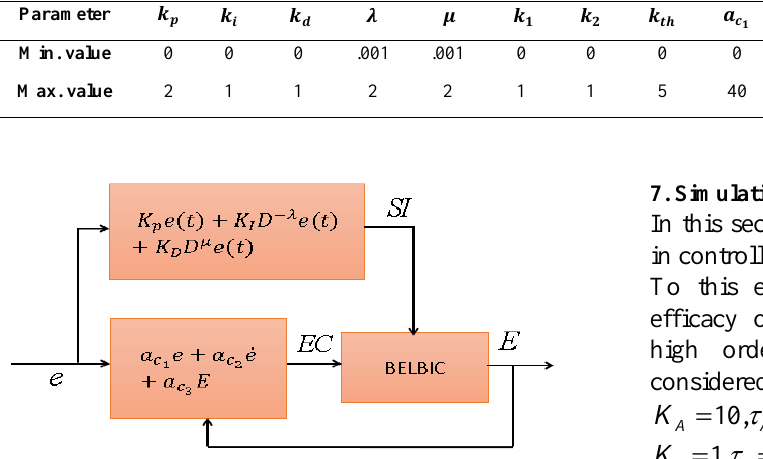
Table 1. Searching range of parameters.